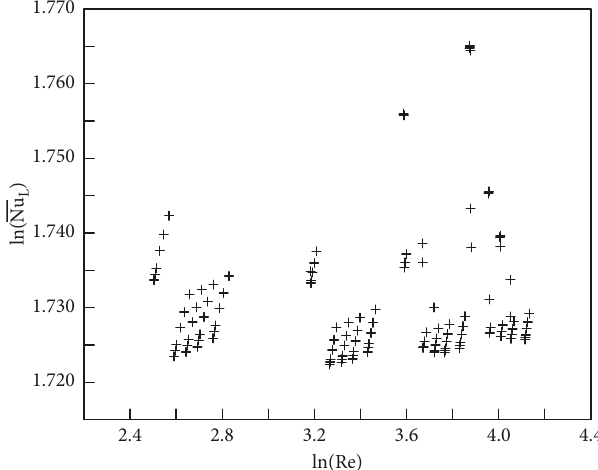
Figure 10: Average Nusselt number plotted against average Reynolds number of the slurry flow on the log-log